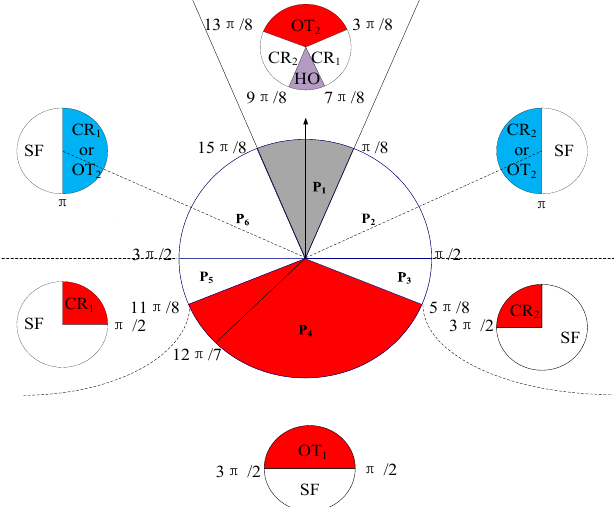
Figure 1. The orientation division of the target ship (TS) (the own ship (OS) is situated at the centre). Table 1. Abbreviations and brief descriptions of the encounter types.